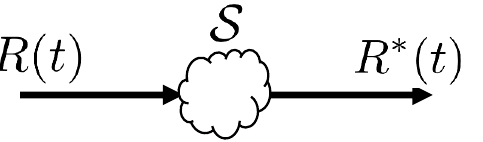
Figure 1. Relationship between input R ( t ) of system S and its output R ∗ ( t )